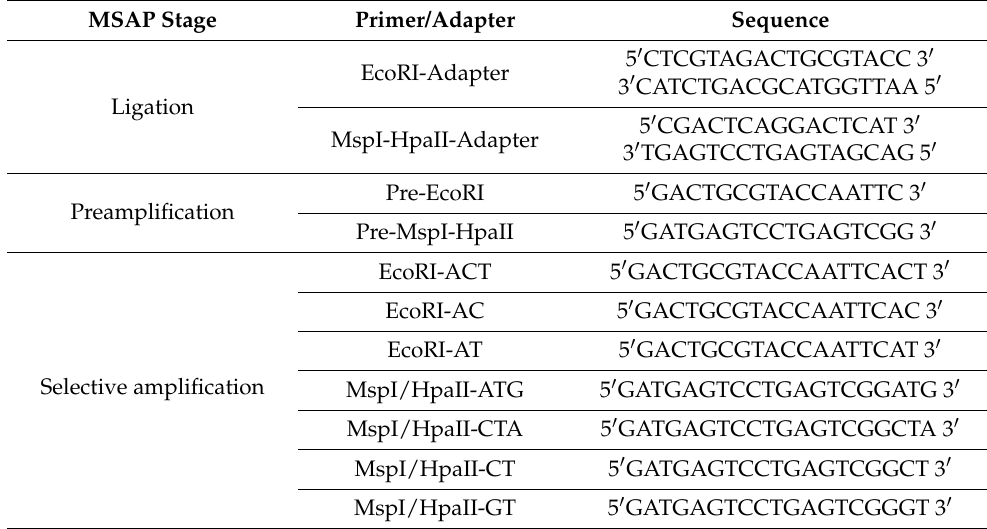
Table 2. Sequences of adapters and primers used for MSAP